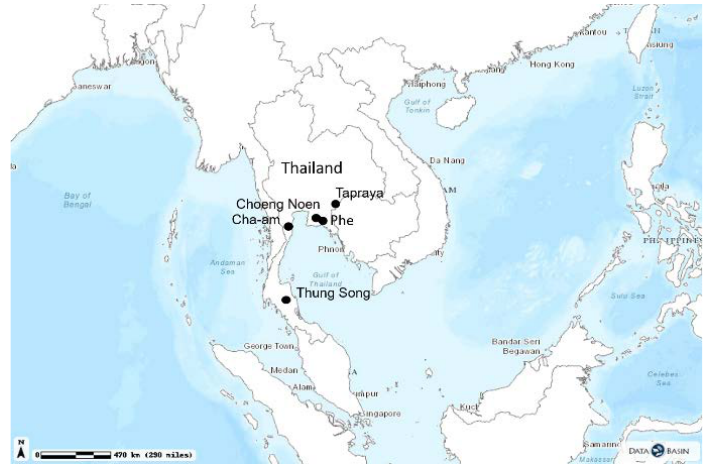
Figure 1. The location of the 5 study areas; (1) Choen Noen, (2) Cha Um, (3) Phe, (4) Thung Song, and (5) Tapraya.